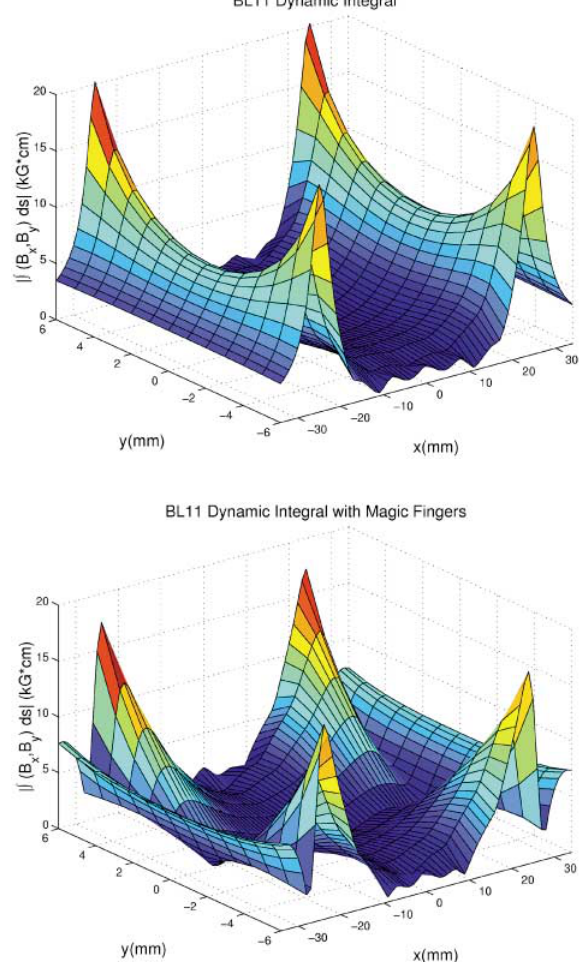
FIG. 10. (Color) Field integral compensation with magic fingers for the midplane (cid:1) y (cid:1) 0 (cid:2) .